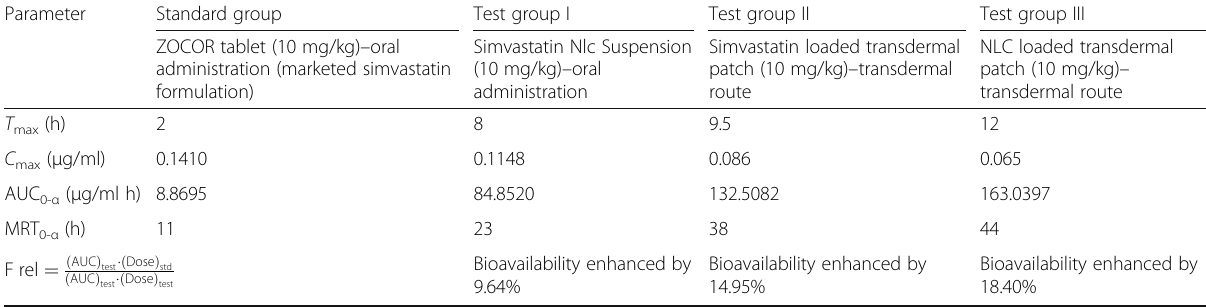
Table 4 Comparative in vivo pharmacokinetic studies data between treatment groups Parameter